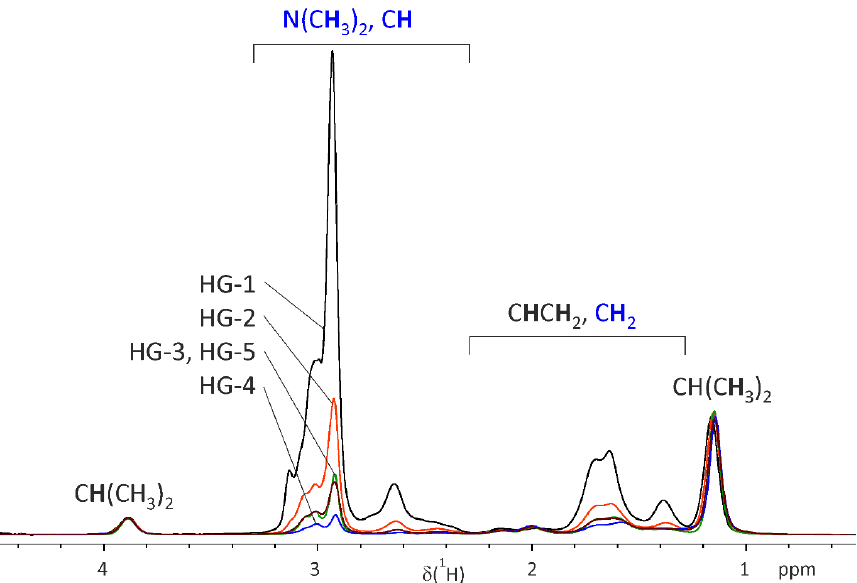
Figure 1. HR-MAS 1 H spectra of HG-1 to -5 swollen in D 2 O. The spectra of HG-3 and HG-5 are almost identical. The signal assignments refer to DMAA (blue) and NIPAAm (black) comonomer.